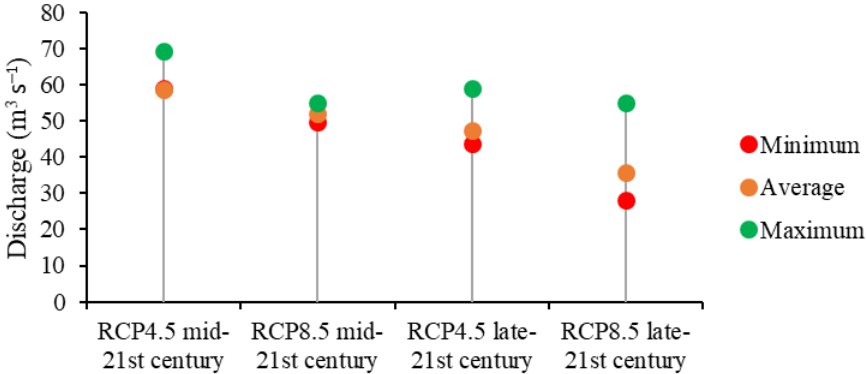
Figure 11. Comparison of projected minimum, maximum, and average discharges during the mid- and late 21st century under RCP 4.5 and 8.5.